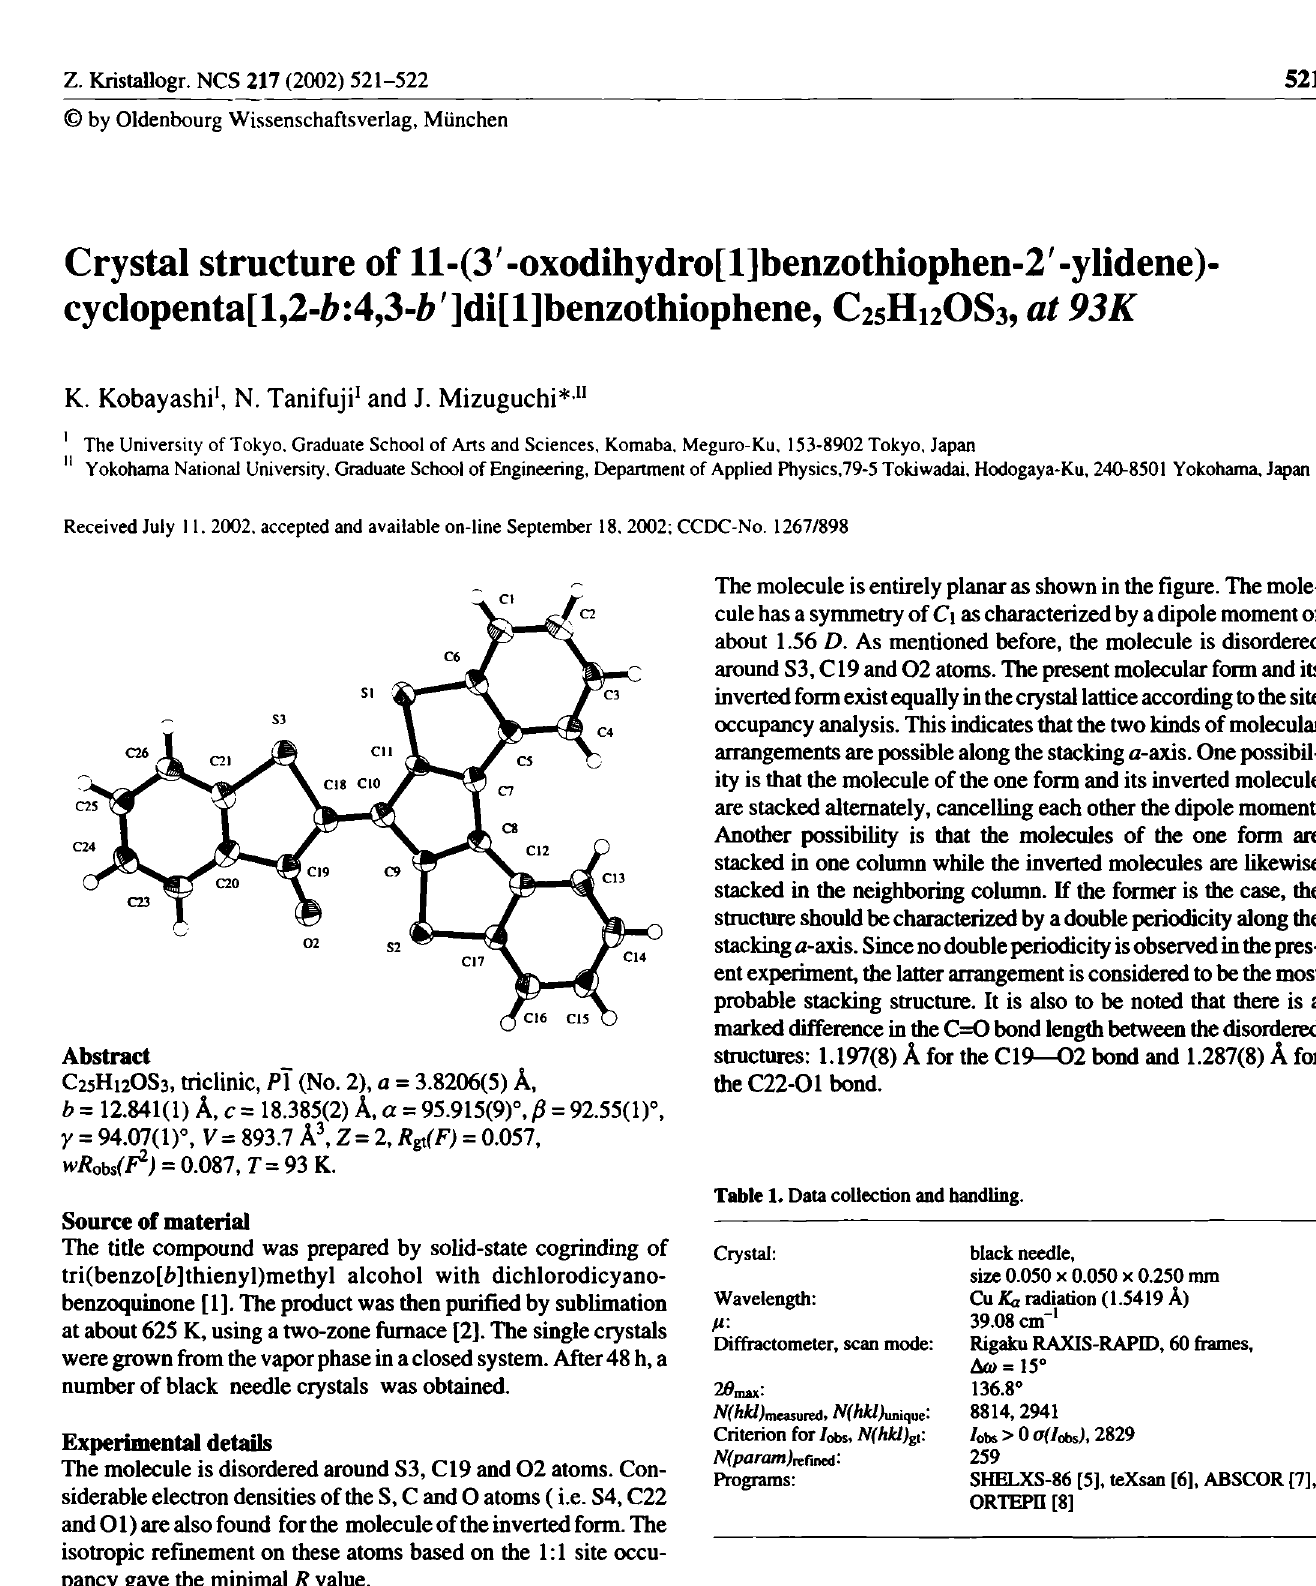
Table 2. Atomic coordinates and displacement parameters (in Â 2